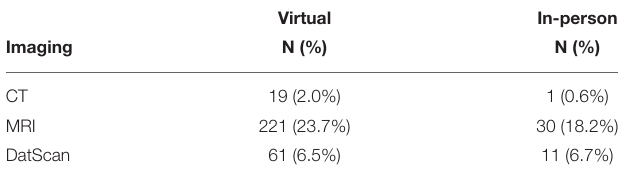
TABLE 2 | Most common 5 diagnosis in both cohorts.